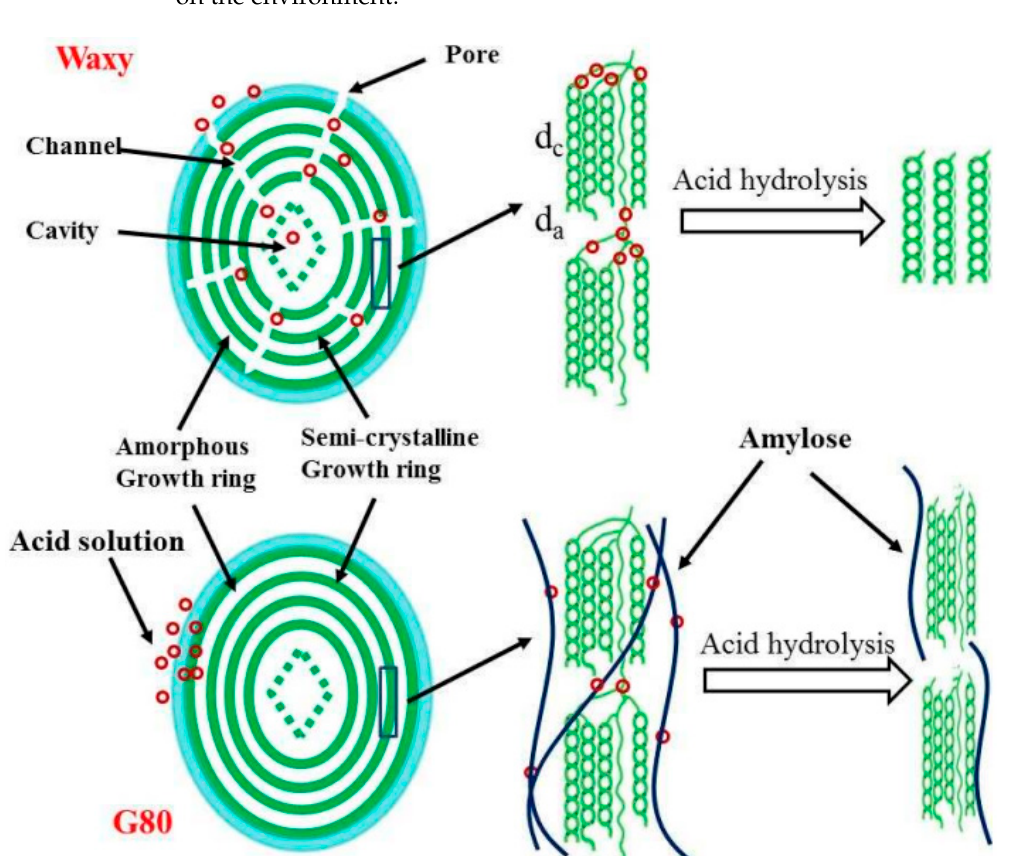
Figure 1. The mechanism of the acid hydrolysis of starch “Reprinted/adapted with permission from Ref. [6]. Copyright © 2017, Elsevier”.